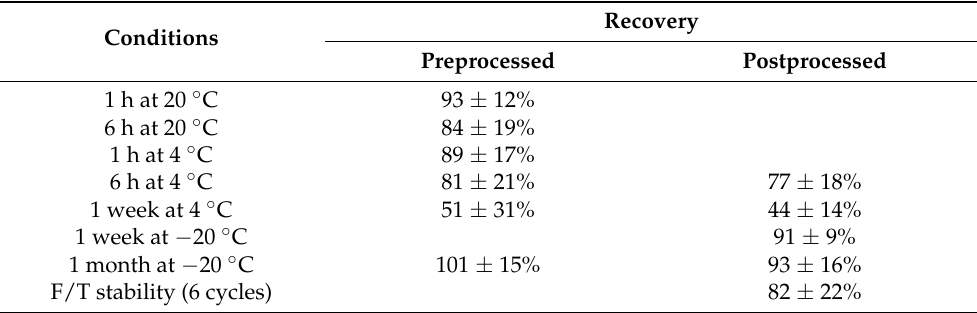
Table 3. Pre- and postprocessed sample stability of at RA under varying conditions. Stability is a change in percentage calculated by measured concentrations divided by nominal concentrations (samples were spiked with 1000 pg · mL − 1 of atRA; n = 4 for each test).